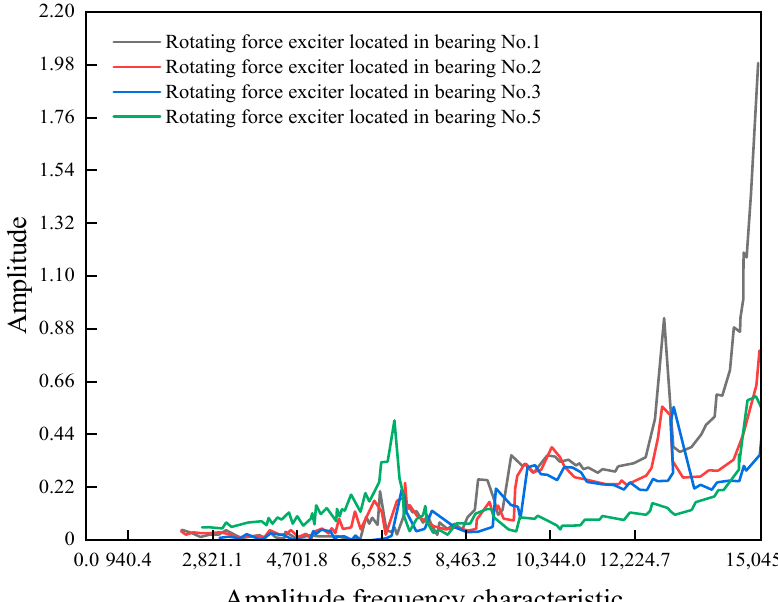
Figure 9. Vibrational transmission ratio amplitude characteristics for radial measuring point of fan casing with exciting force acted at different locations.